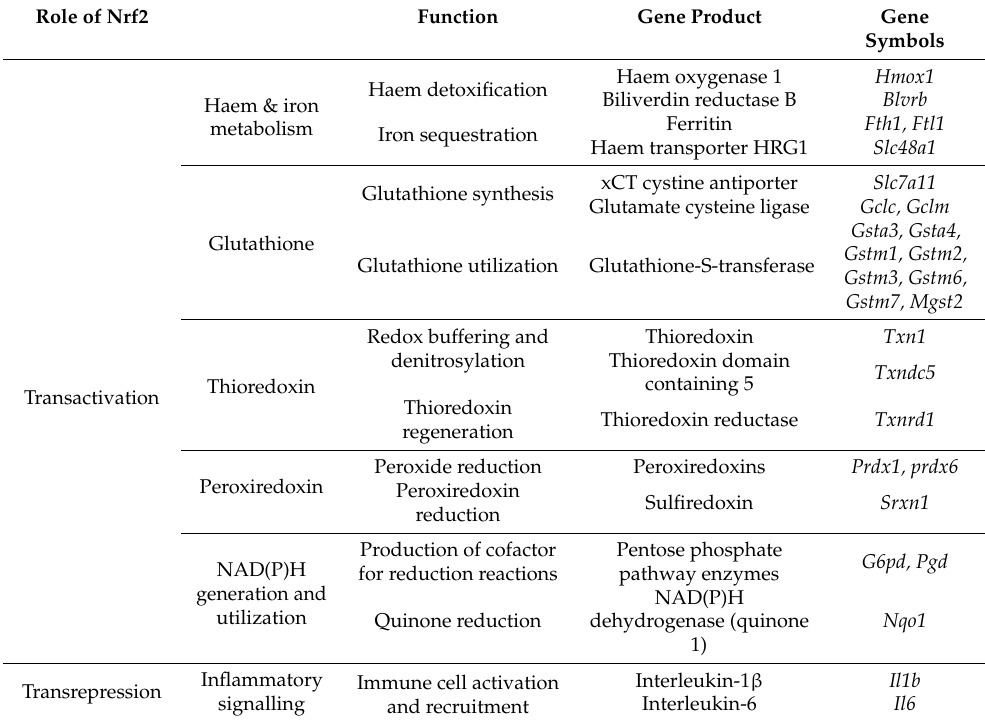
Table 1. Directly Nrf2-regulated genes. Non-exhaustive list of canonical directly Nrf2-regulated genes, supported by chromatin immunoprecipitation